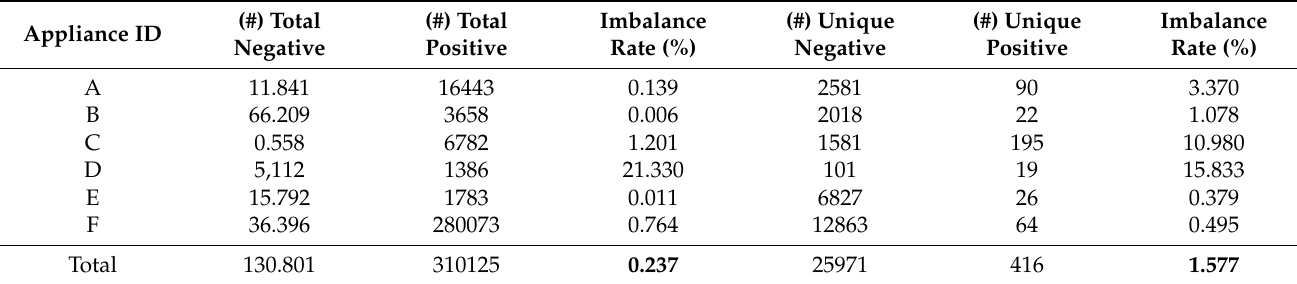
Table 2. Statistics of the enterprise dataset.